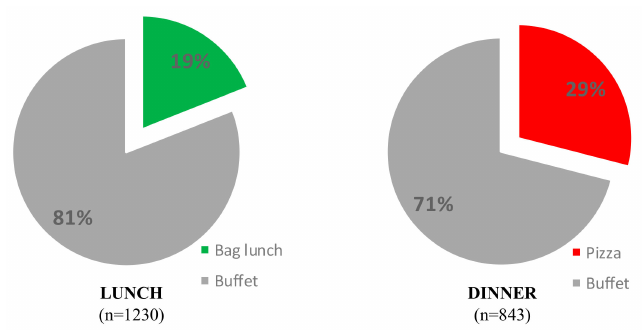
Figure 1. Uptake of new meal options measured via direct